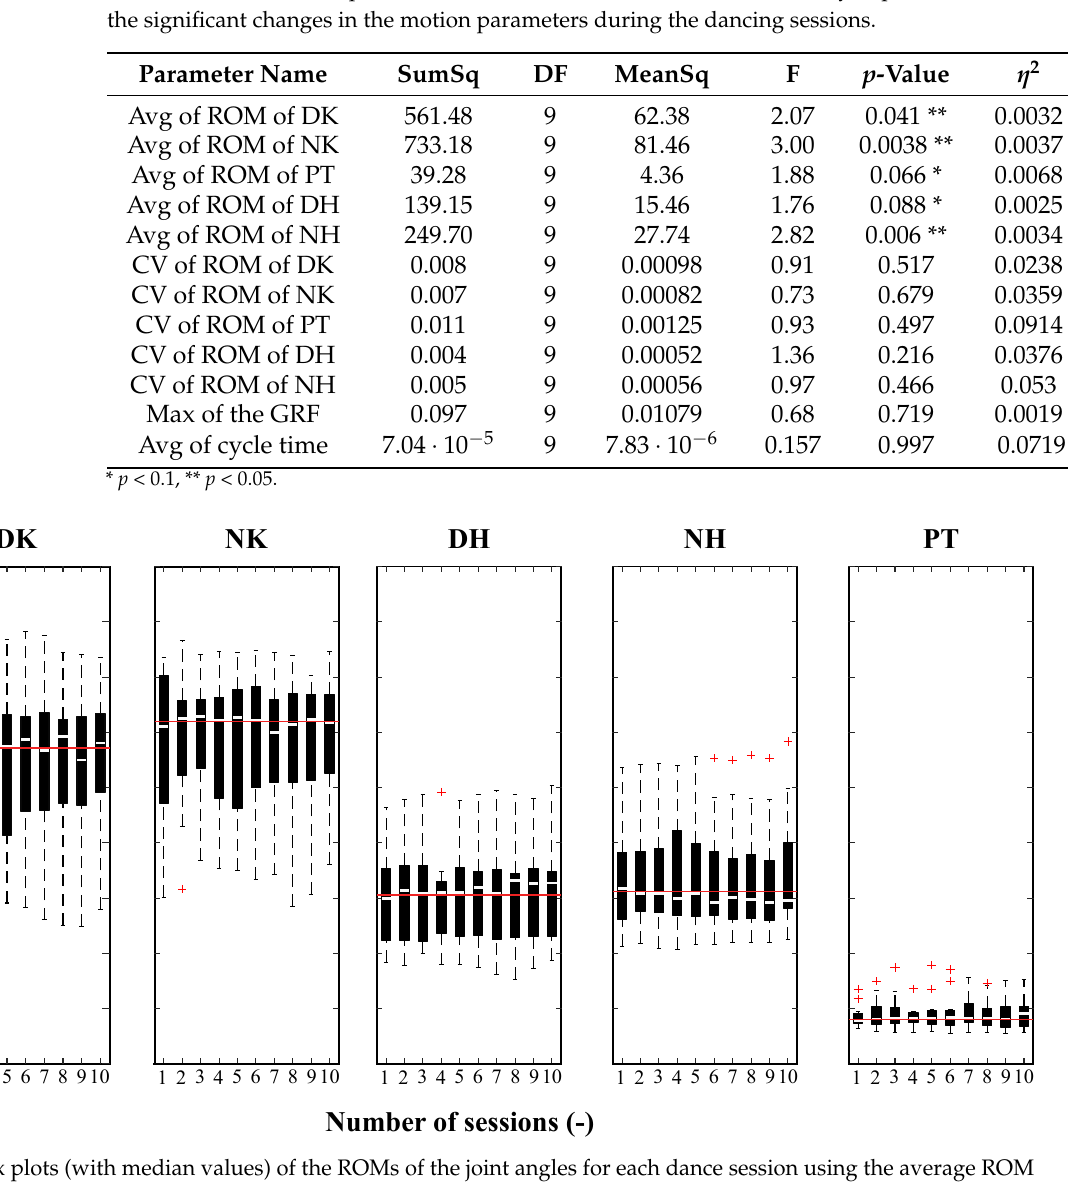
Figure 2. The box plots (with median values) of the ROMs of the joint angles for each dance session using the average ROM data from all the dancers. The overall median of the ten sessions is denoted with a horizontal red line on each subplot. The numeric data are detailed in Supplementary Material